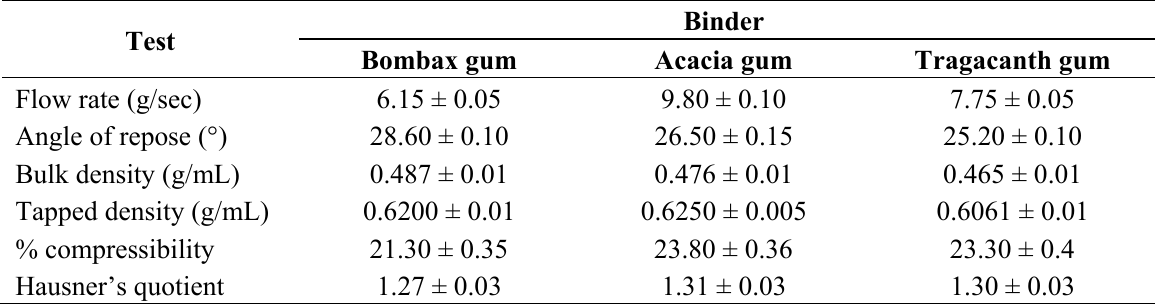
Table 1. Analysis of granules prepared with different binders.